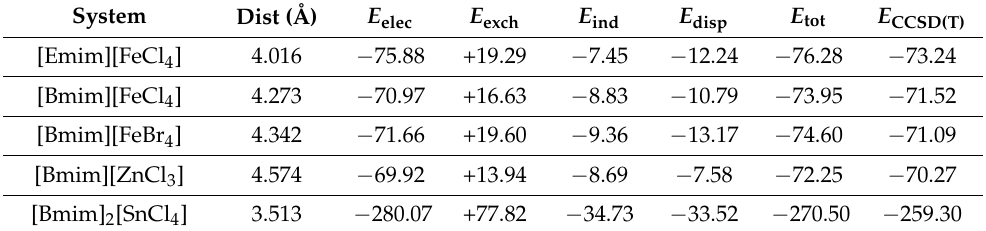
Table 1. Contributions to the interaction energy (kcal mol − 1 ) using SAPT0. Dist stands for the distance of the minimum interaction energy between the CM. E elec , E exch , E ind , and E disp stand for the electrostatic, exchange, induction, and dispersion contributions, respectively. E tot stands for the total interaction energy at SAPT0 and E CCSD(T) for the total interaction energy at DLPNO-CCSD(T). System Dist (Å) E elec E